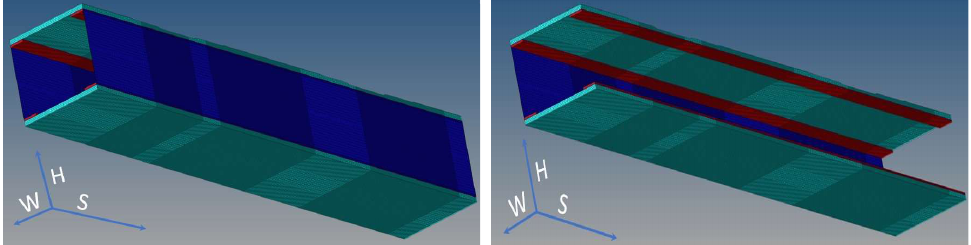
Figure 34. An overview of the experimental set-up: acquisition PC, optical interrogator, optical table, test rig, test article.